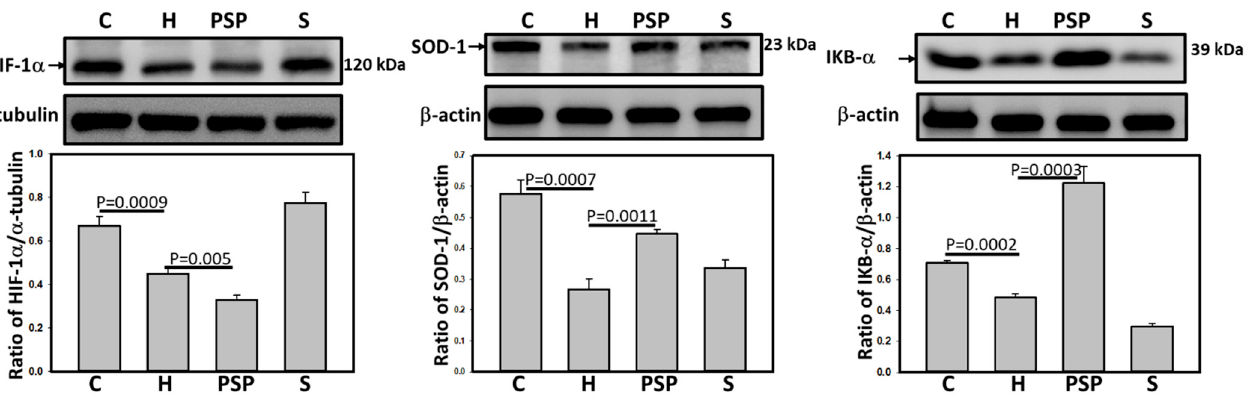
Figure 6. PSP treatment increased SOD-1 and IkB levels but reduced HIF-1 α levels. Immunoblot examination was carried out to detect SOD-1, HIF-1 α , IkB levels. The β -actin or α -tubulin was used as the loading control. The relative image density was quantified by the densitometer. Ratio values calculated from triplicate experiments were represented as the mean ± SD shown in lower panel.